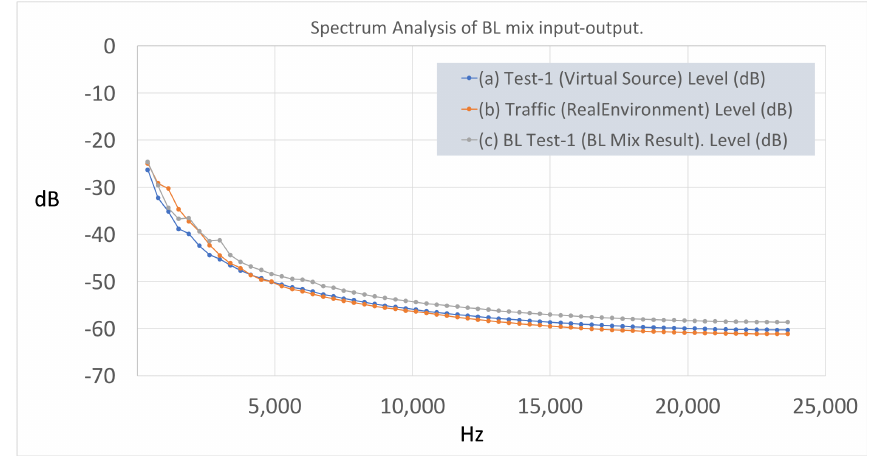
Figure 14. Spectrum analysis of BL mix input-output. (a) Test-1 (virtual source). (b) Traffic (real environment). (c) BL test-1 (BL mix result).